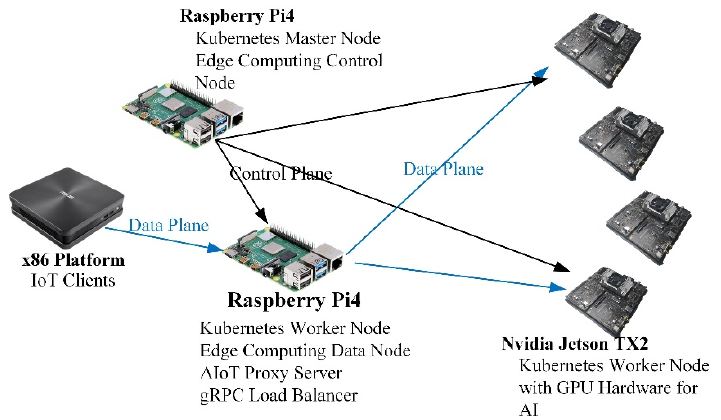
Figure 8. Person Re-ID microservice over AIoT EC gateway system validation environment.